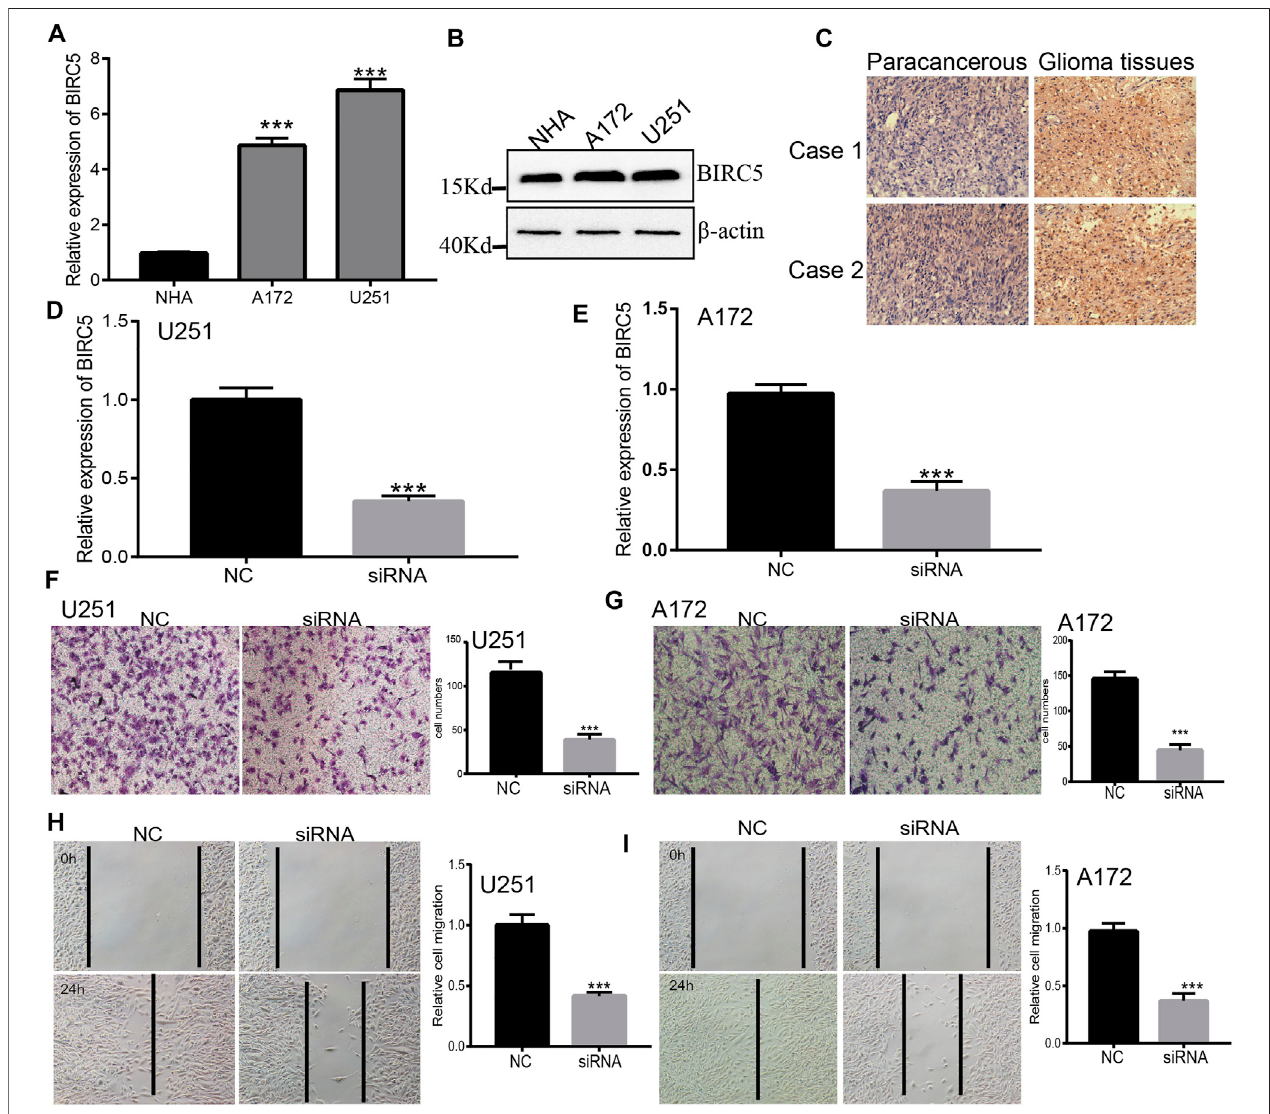
FIGURE 10 | Depletion of BIRC5 inhibits glioma cells migration. (A,B) The expression of BIRC5 in normal human astrocytes cells (NHA) and glioma cell lines (A172 and U251) examined by qRT-PCR and Western blot assay. (C) IHC analysis of BIRC5 expression in glioma cancer tissues. Scale bar, 50 μ m. (D,E) The expression of BIRC5 in U251and A172cells treated withsiRNAs (siRNA - BIRC5 #NC,siRNA- BIRC5 #)measured byqRT – PCR.* p < 0.05, one-way ANOVA test forthe comparison of the two groups. (F – I) Transwell and Wound healing assay of the glioma cancer cell lines U251 and A172 treated with shRNAs. * p < 0.05, one-way ANOVA test for the comparison of the two groups. Scale bar, 100 μ